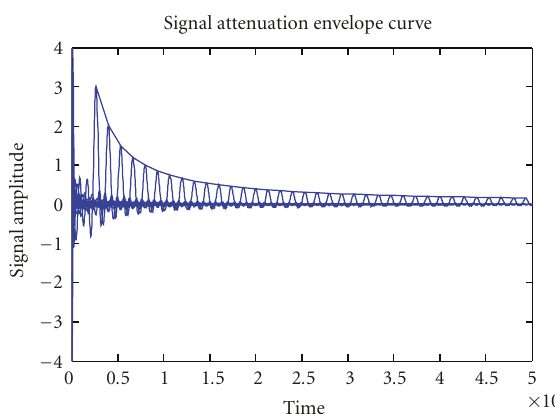
Figure 5: Channel fading signal envelope curve without sinusoid FM